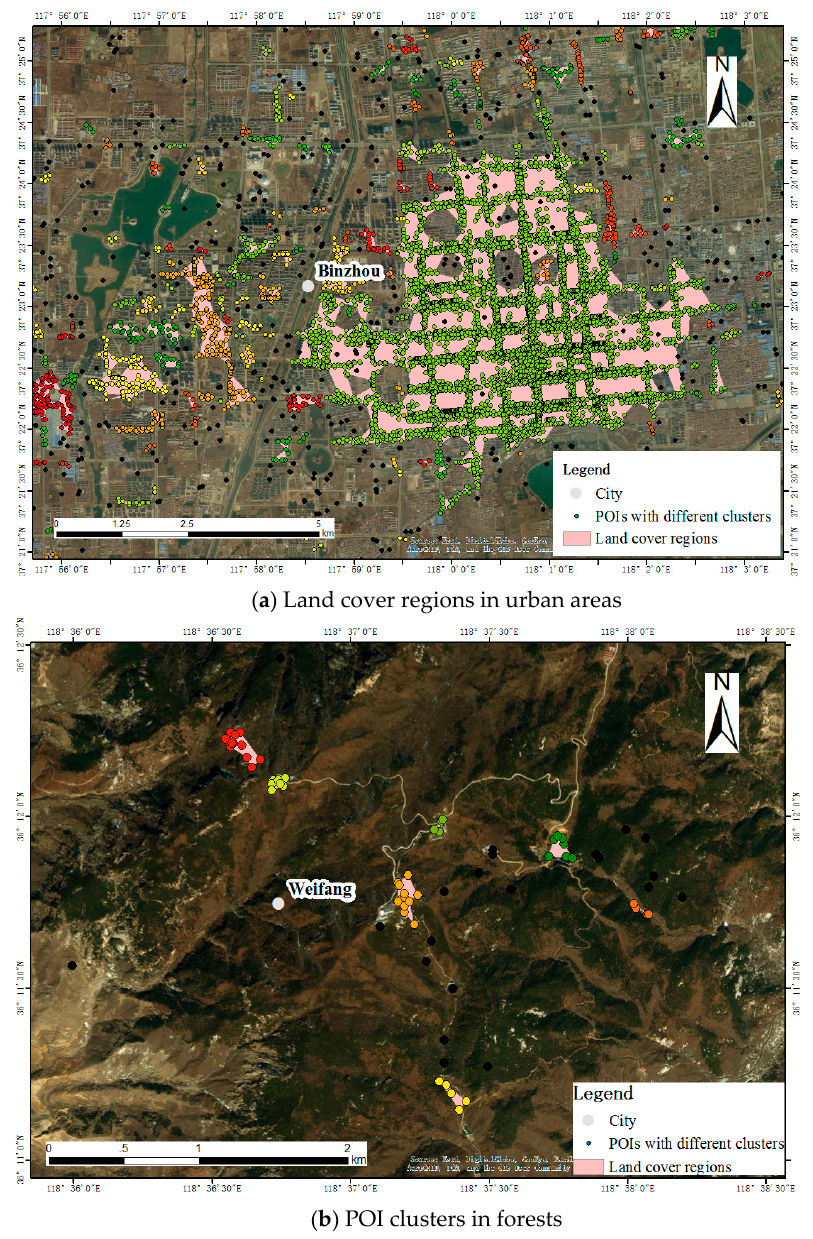
Figure 11. Extracted regions based on POI clusters in two areas in Shandong Province.